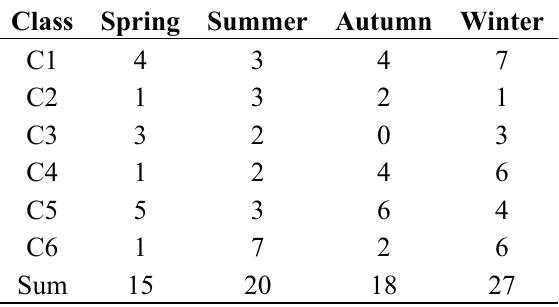
Table 5. Number of PM 2.5 Pollution Episode from different clusters in each season.